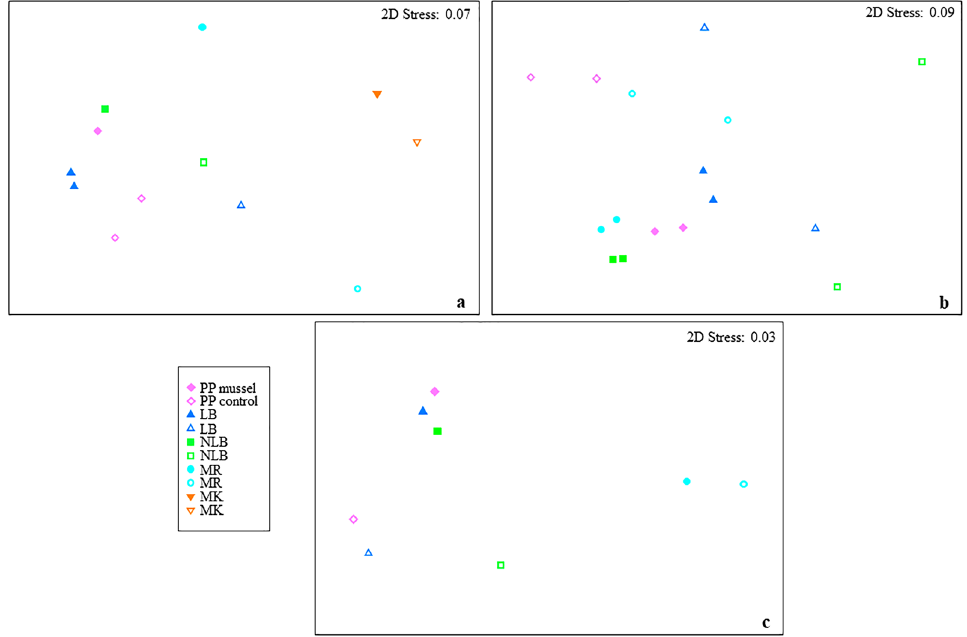
Figure 3. Two-dimensional non-metric multidimensional scaling (nMDS) plots for visualisation of differences in assemblage structure observed between sites (colour) and mussel bed status (fill). ( a ) Mobile community (points represent all available reps from un-baited video cameras); ( b ) epifauna/benthic invertebrate community (ordination showing two transects per site); and ( c ) macrofaunal community (calculated from the distance between centroids where n = 8 sediment cores for the combined factor SiteStatus). Ordinations created from Bray–Curtis similarity matrices on square-root transformed data using PRIMER v. 7 (Clarke & Gorley 2015; available at http:// www. primer- e.